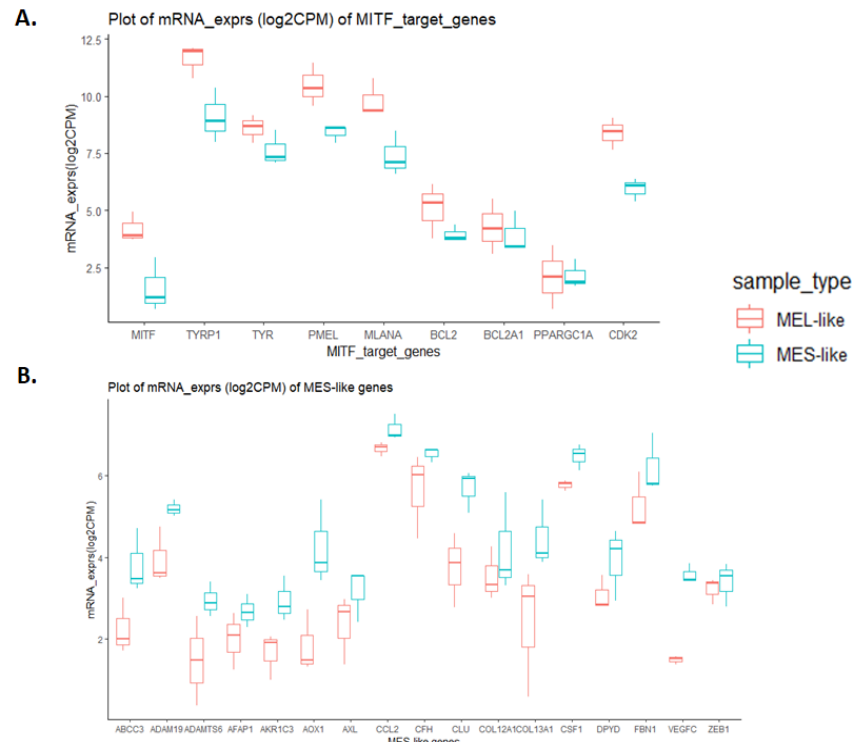
Figure 7. Boxplot diagrams of expression levels of classic melanocytic and mesenchymal gene markers in melanoma samples. Log2CPM mRNA expression values of MEL and MES groups were used. Boxplots indicate the median (thick bar), first and third quartiles (lower and upper bounds of the box, respectively), and lowest and highest data value within 1.5 times the interquartile range (lower and upper bounds of the whisker). Boxplot diagrams of expression levels of MITF target genes, highly expressed in MEL-like samples ( A ) and of mesenchymal gene markers, highly expressed in MES-like samples ( B ).